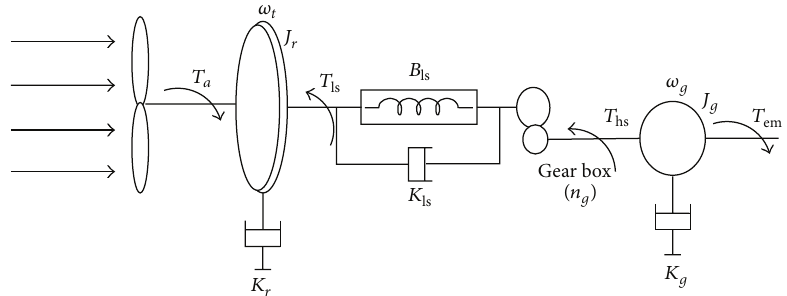
Figure 5: Two-mass model of the aero